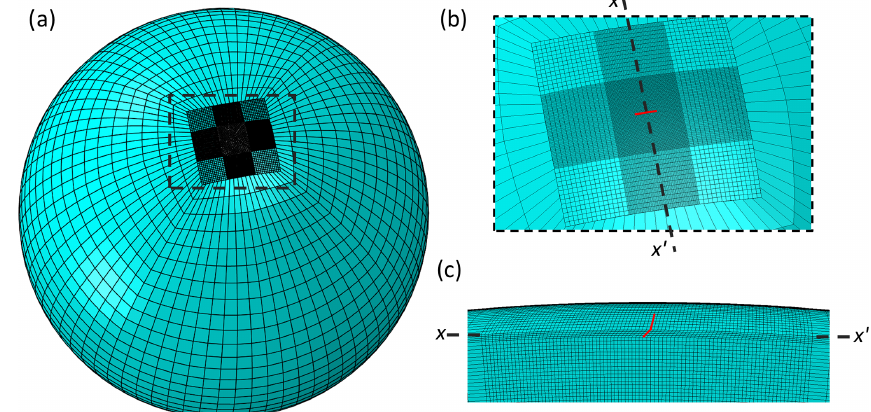
Figure 1. Abaqus mesh; (a) full global mesh with high-resolution fault region surrounded by lower-resolution elements; (b) close-up plan view of the fault region with fault marked in red and cross section x – x (cid:48) shown in panel (c) ; (c) cross section x – x (cid:48) (as marked in panel b ) through the fault region for 45 ◦ dipping fault with the fault marked in